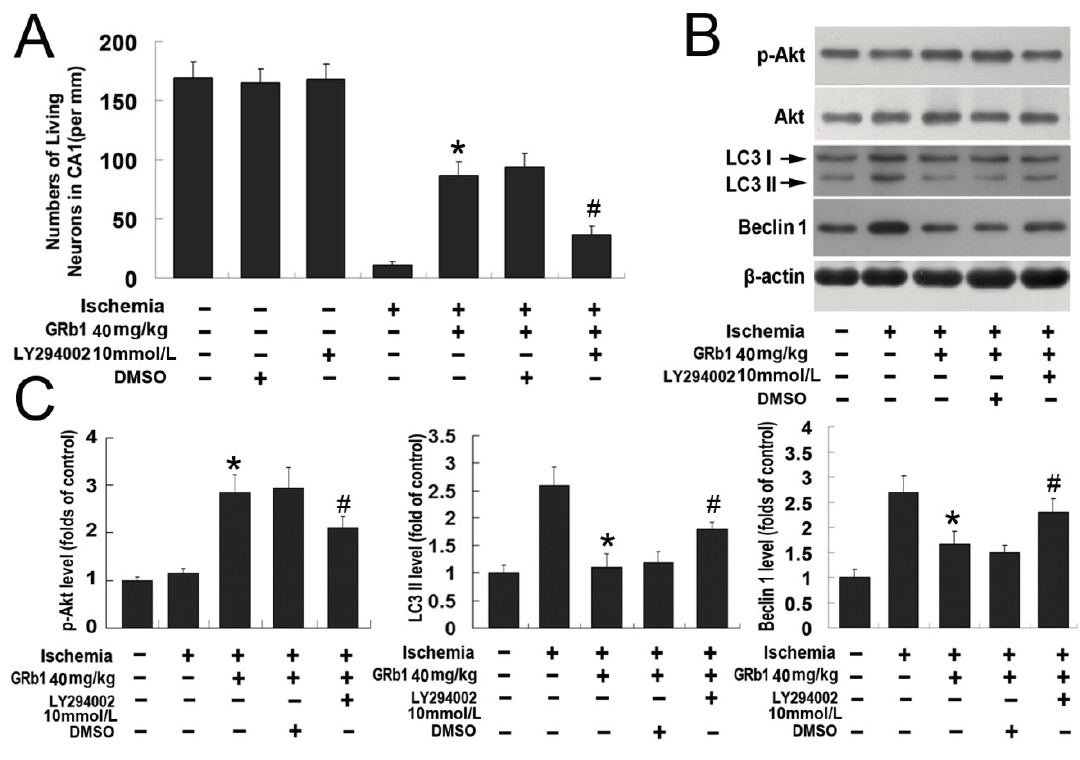
Figure 5. PI3K/Akt pathway contributed to the protection of ginsenoside Rb1 on neuronal death caused by transient global ischemia. ( A ) Statistical analysis of living neurons in the CA1 region. PI3K inhibitor LY294002 suppressed the protection of GRb1 at 40 mg/kg against neuronal death caused by transient ischemia, but its solvent DMSO did not; ( B ) Images of western blotting; ( C ) Statistics of optical densities of immunoblots. GRb1-induced up-regulated expression of phosphor Akt at Ser473 and down-regulated level of LC3II were all attenuated by pretreatment with LY294002. * p < 0.01 versus OGD group; # p < 0.01 versus GRb1 group. Each experiment was performed four